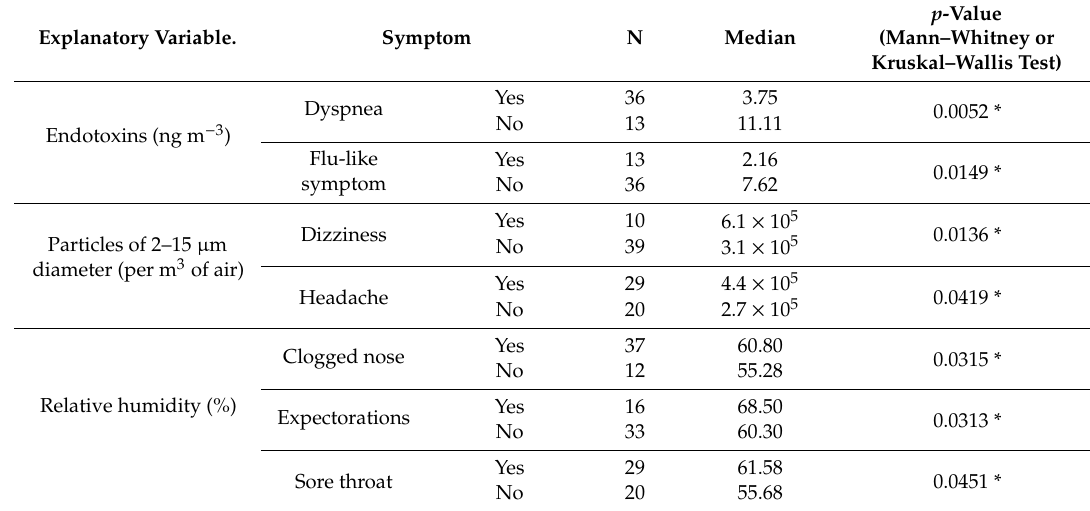
Explanatory Variable.